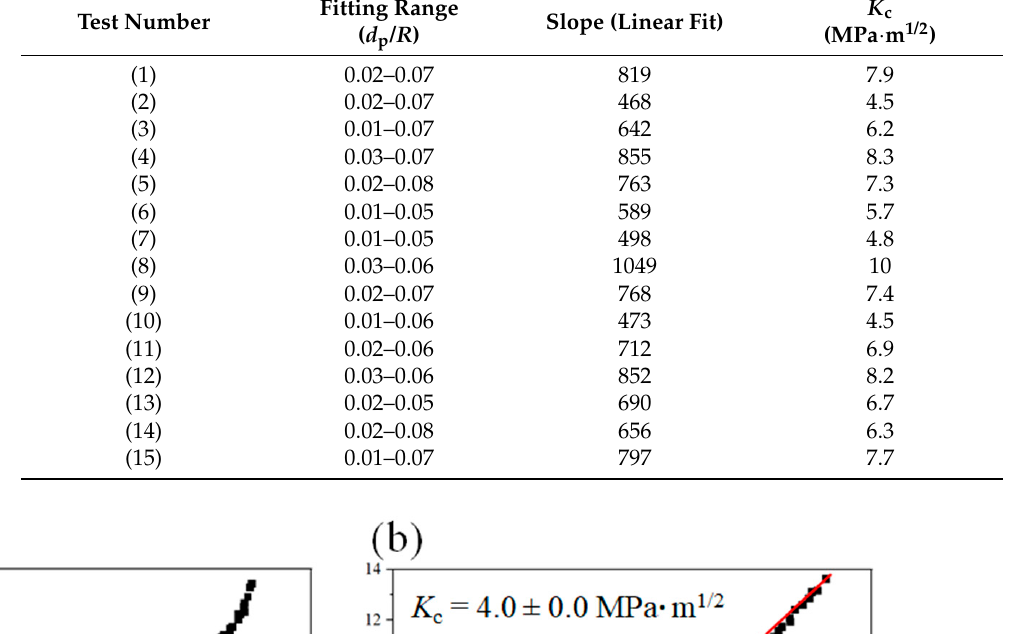
Table 3. The fi tt ing range of F l ( d p /R ) curves and the related slopes used for the calculation of the fracture toughness of the Al 2 O 3 -ZrO 2 coatings.